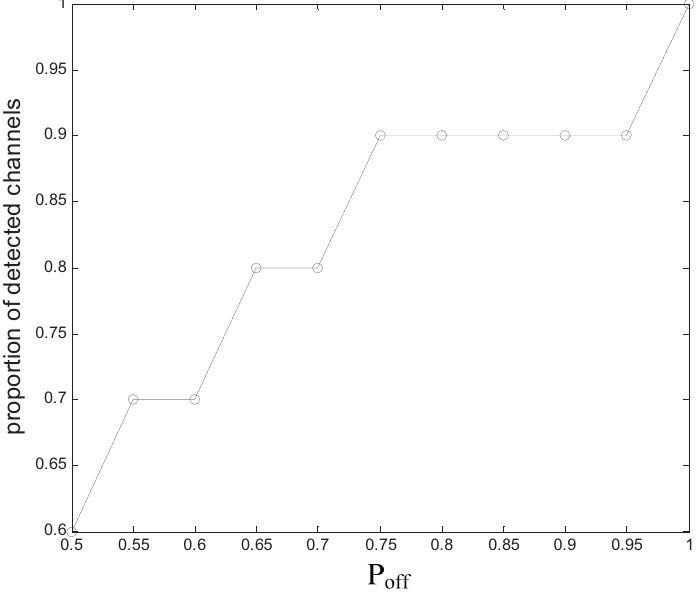
Figure 13. Proportion of detected channels vs. average channel idle